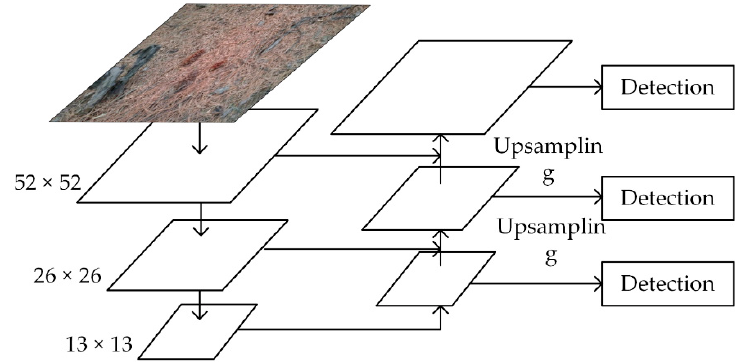
Figure 4. Multi-scale feature fusion.